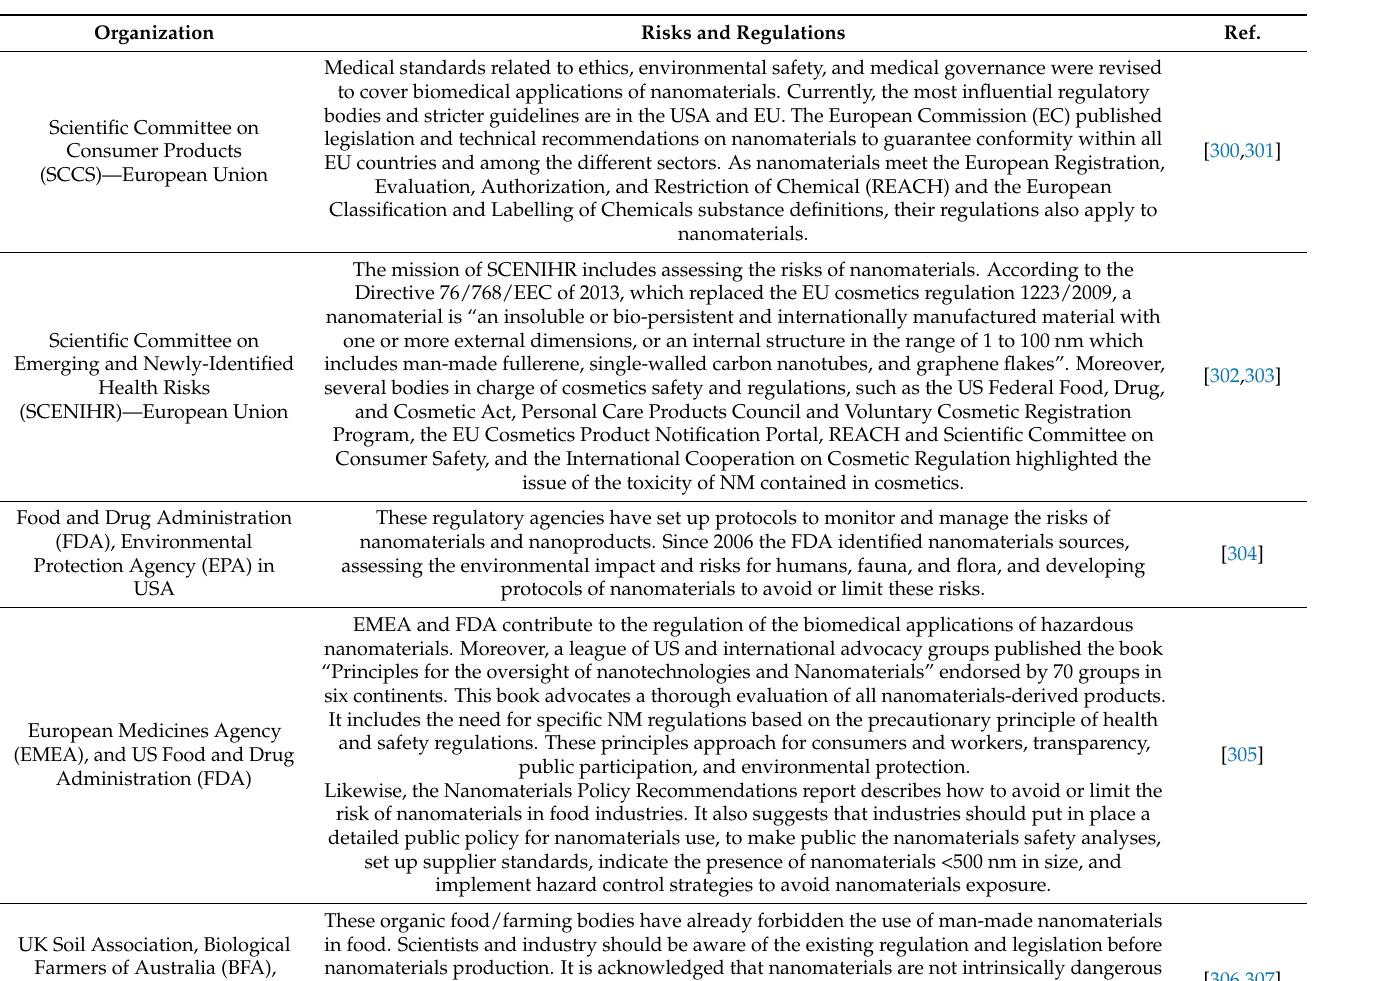
Table 7. Specific regulatory bodies and recommendations for assessing the nanomaterial